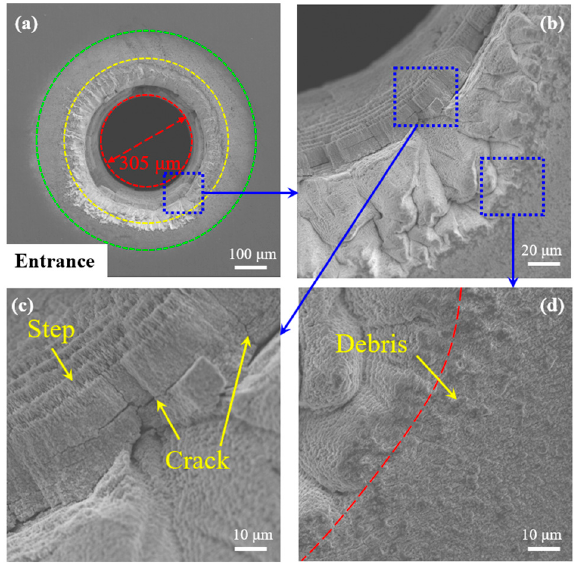
Figure 10. Enlarged view of the 2-2-3-4-5-1 entrance hole morphology micro area ( a ) entrance hole; ( b – d ) enlarged view.